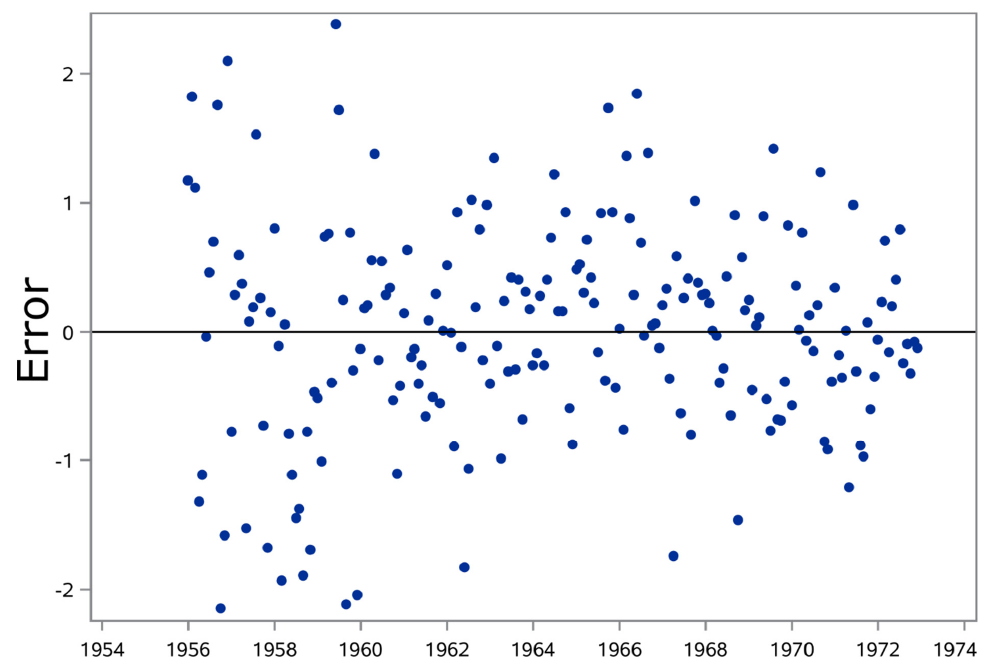
Figure 4. White noise residuals produced by the autoregressive model.